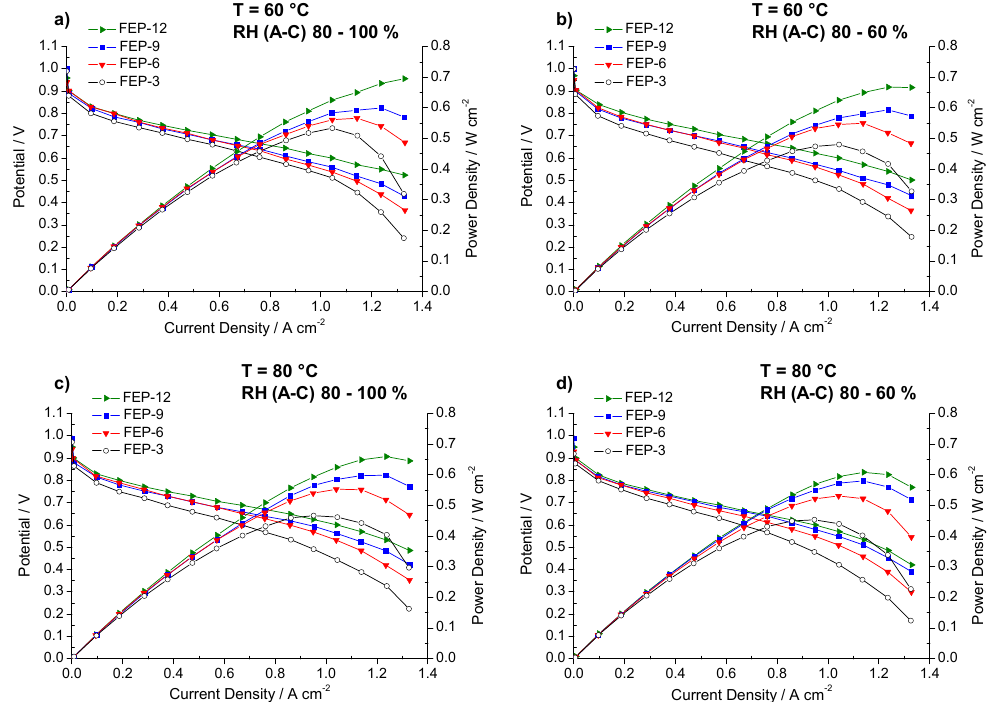
Figure 3. Polarization and power density curves obtained for fuel cells assembled with all the prepared GDMs. Operating conditions: ( a ) 60 ◦ C, relative humidity RH (anode-cathode) (A-C): 80–100%; ( b ) 60 ◦ C, RH (A-C): 80–60%; ( c ) 80 ◦ C, RH (A-C): 80–100%; and ( d ) 80 ◦ C, RH (A-C):